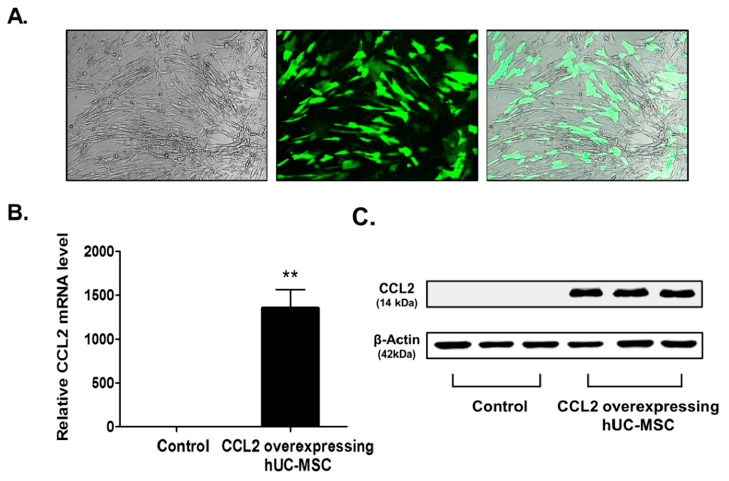
Figure 1. Confirmation of CCL2 overexpression following transfection into hUC-MSCs. ( A ) At 24-h post-transfection, hUC-MSCs observed in the bright field expressed GFP by fluorescence microscopy, and ( B ) RT-PCR results indicated CCL2 mRNA levels. Data represent fold changes relative to GAPDH and are presented as the mean ± SEM. ** p < 0.01, Student’s t test. ( C ) Western blot analysis showing CCL2 protein levels at 24-h post-transfection. CCL2-specific bands were quantified and normalized against those of β -actin. Scale bar = 100 µ